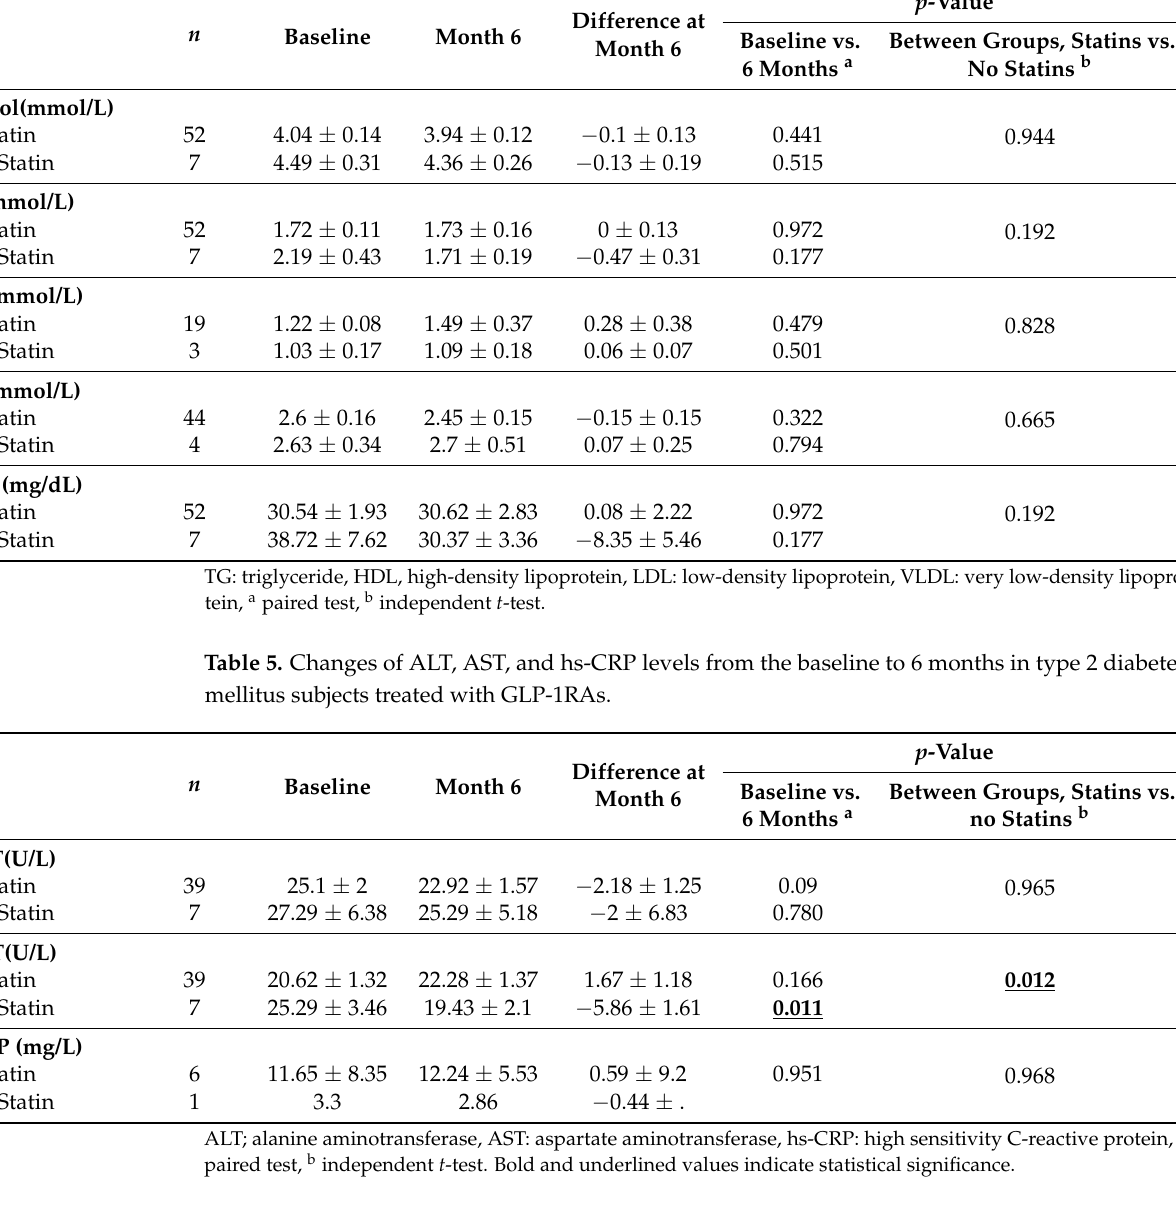
Table 6. There was a negative correlation between the dose and changes in LDL r = − 0.326, with a p -value of 0.024. Conversely, the changes in cholesterol also negatively correlate with the dose, with the p -value trending toward a significant